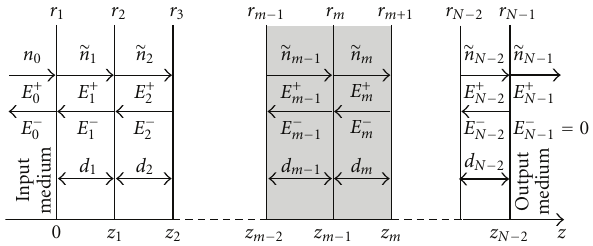
Figure 4: Schematic geometry of the multilayer structure consisting of N media (including the input/output ones) with two highlighted ( m − 1)th and m th layers having an interface at z m − 1 specified by the Fresnel reflection coe ffi cient r m = s m ρ m exp( i s m φ m ).